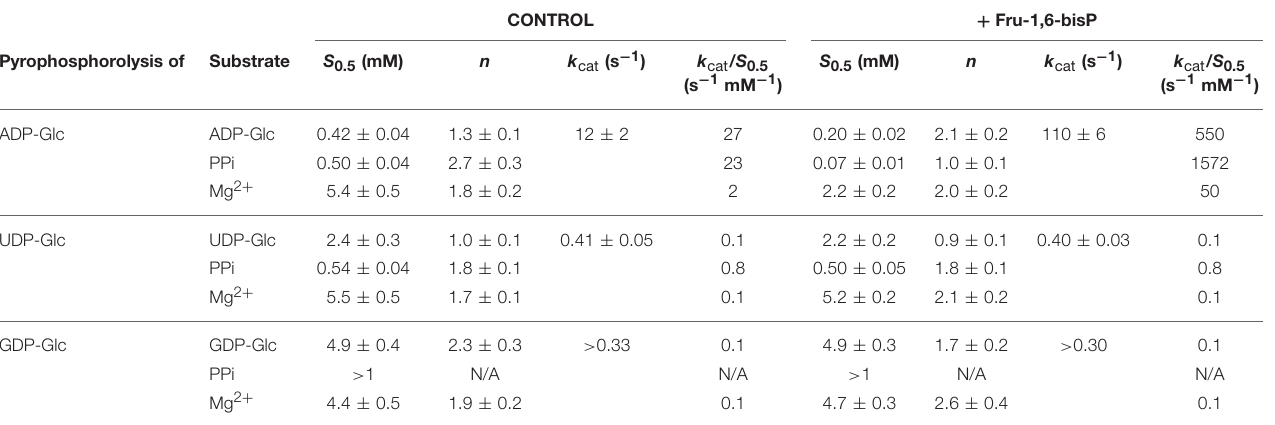
TABLE 1 | Kinetic parameters for substrates of the E. coli ADP-GlcPPase in the synthesis direction. Synthesis of